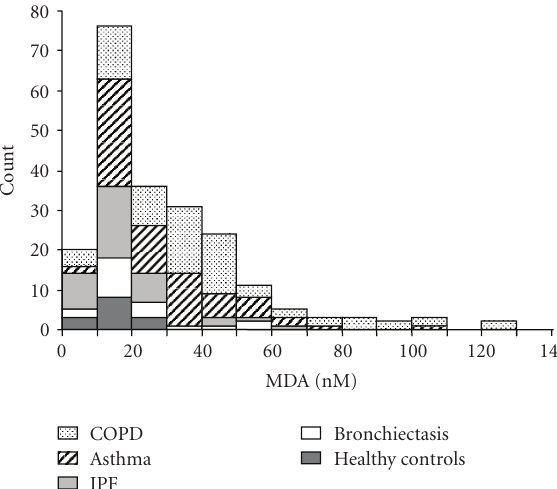
Figure 2: Distribution of Malondialdehyde (MDA) in the di ff erent categories of subjects. COPD: chronic obstructive pulmonary disease; IPF: Idiopathic pulmonary fibrosis.